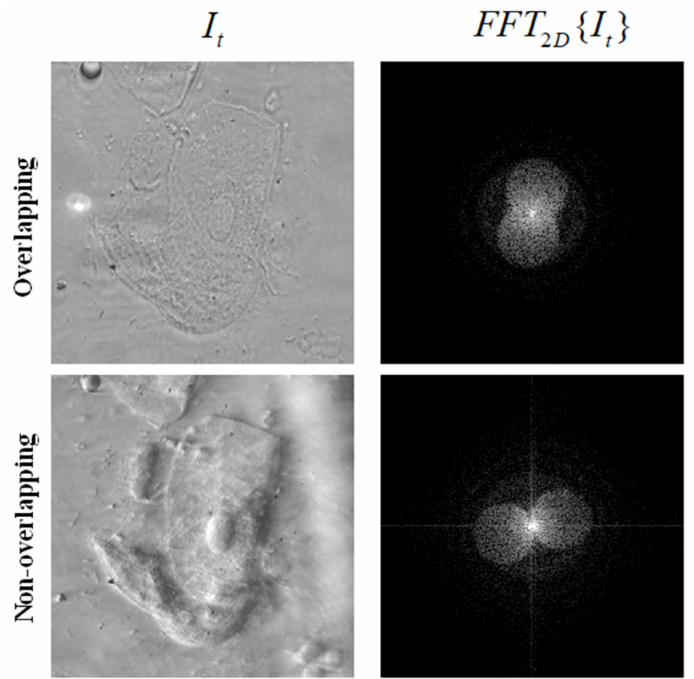
Figure 7. Effect of misalignment on the captured intensity images under LED illumination. An il- lumination angle smaller than the maximum angle allowed by the NA of the objective lens, results in overlapping spectra (circles), and we obtain low contrast images. This is not the case when the illumination angle is maximized, and the spectra do not overlap.